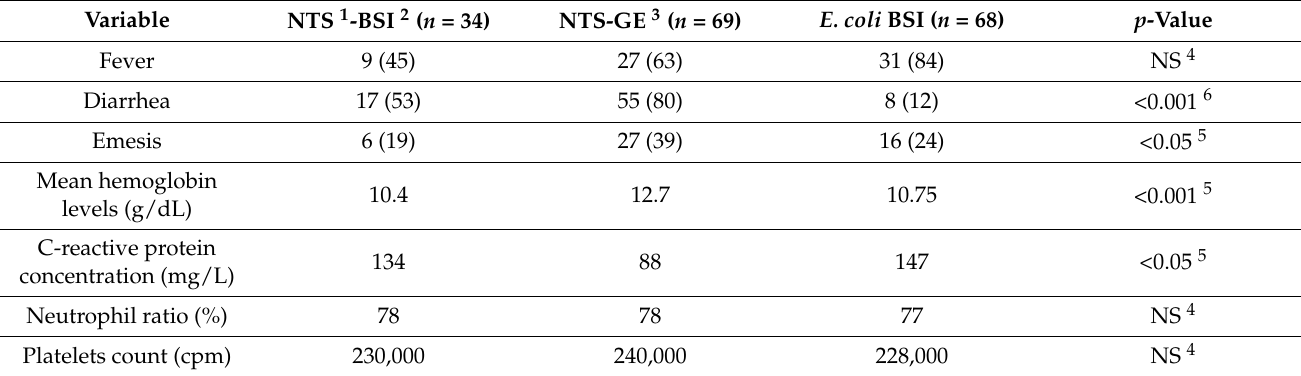
Table 2. Gastrointestinal symptoms and laboratory findings at